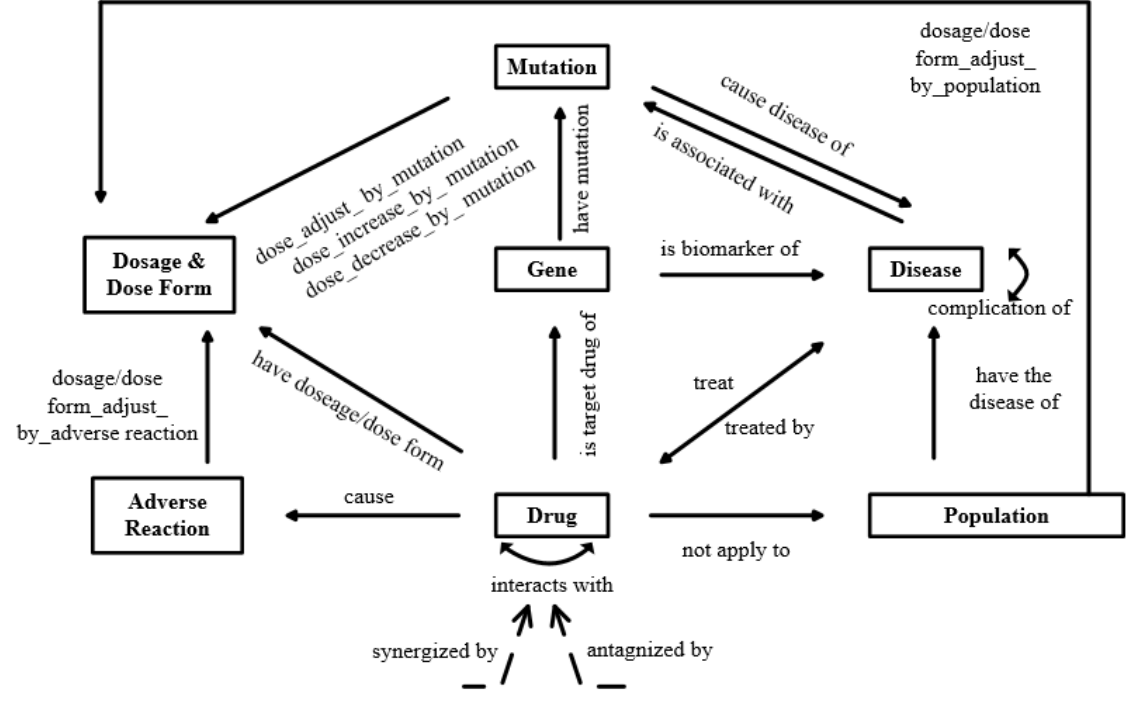
Figure 5. Overview of pharmacogenomics knowledge